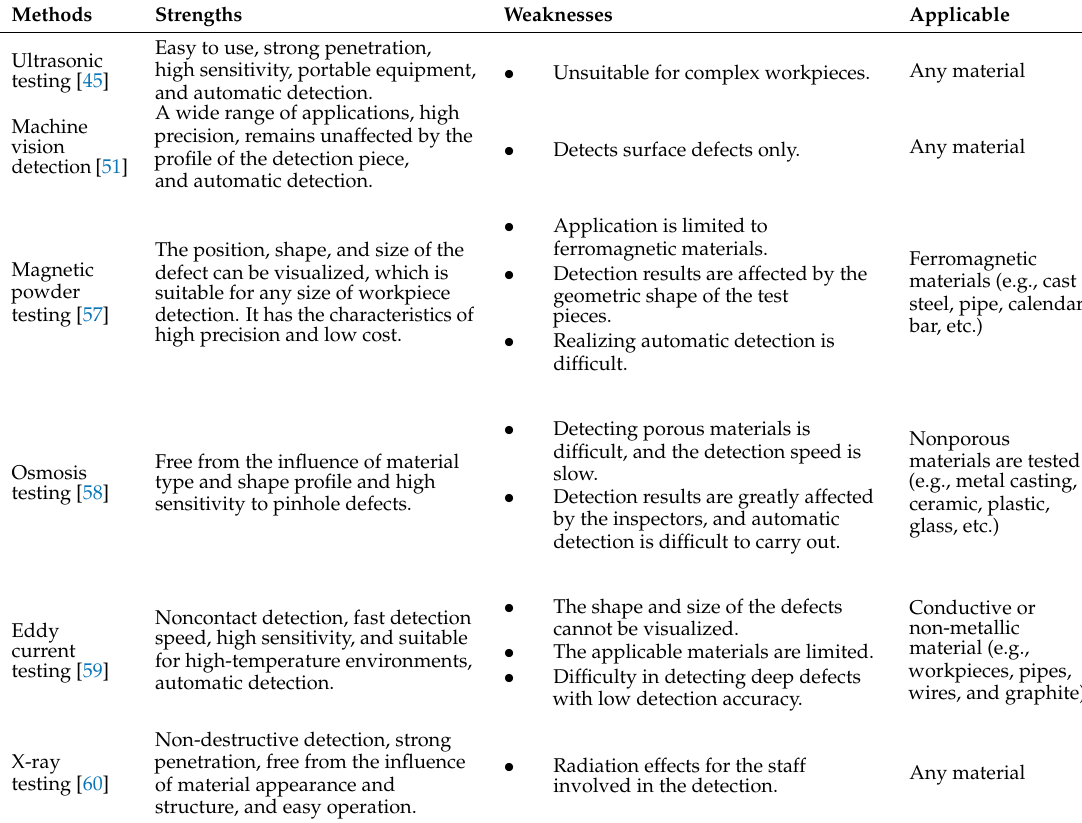
Table 1. Comparison of common defect-detection